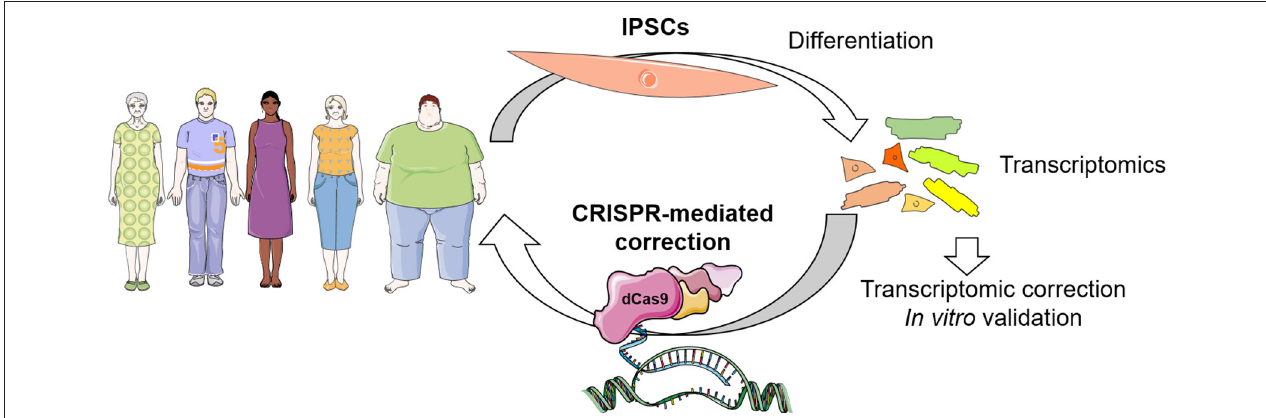
FIGURE 2 | Envisioned concept of CRISPR-dCas9 system in patient-specific therapeutics. Identification of transcriptional networks dysregulation can be achieved in patient specific iPSC-derived cells, which can be corrected by CRISPR-mediated gene modulation in vitro for validation, and finally in vivo for personalized therapeutics in the near